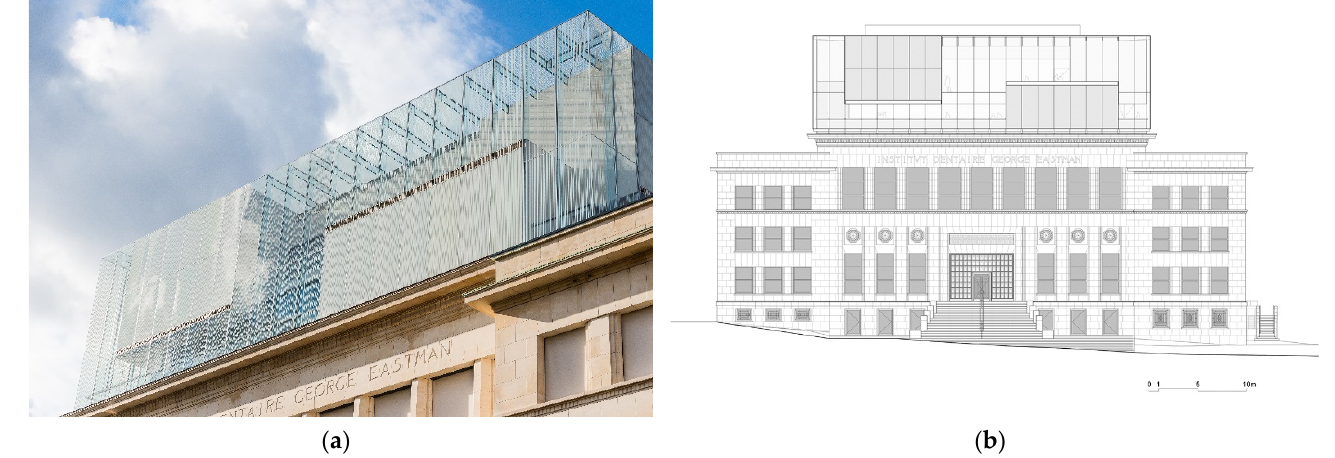
Figure 15. House of European History in Brussels: ( a ) glass upper extension (© Christian Fabris); ( b ) eastern façade (© Chaix & Morel et Associés/JSWD).